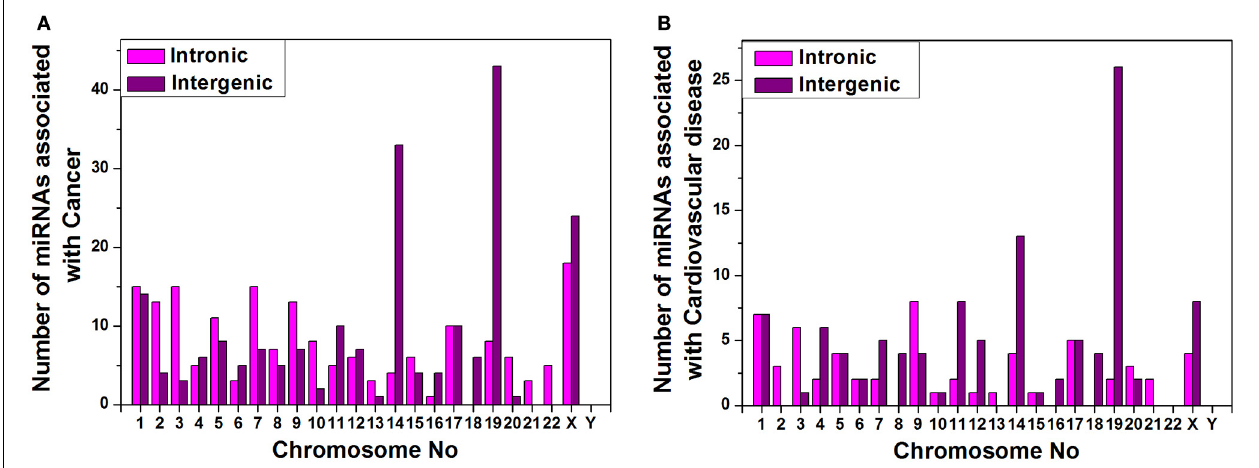
FIGURE 6 | miRNA sub-types associated with diseases. Counts of intronic and intergenic miRNAs associated with cancer (A) and cardiovascular disease (B) in different human chromosomes.